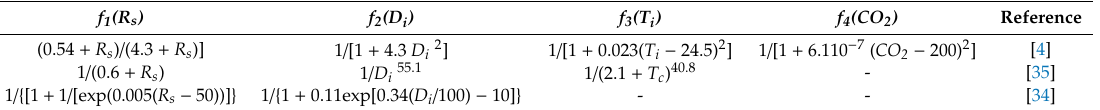
Table 1. Mathematical functions f 1 , f 2 , f 3 , and f 4 of Equation (14) and their constant coe ffi cients found in the